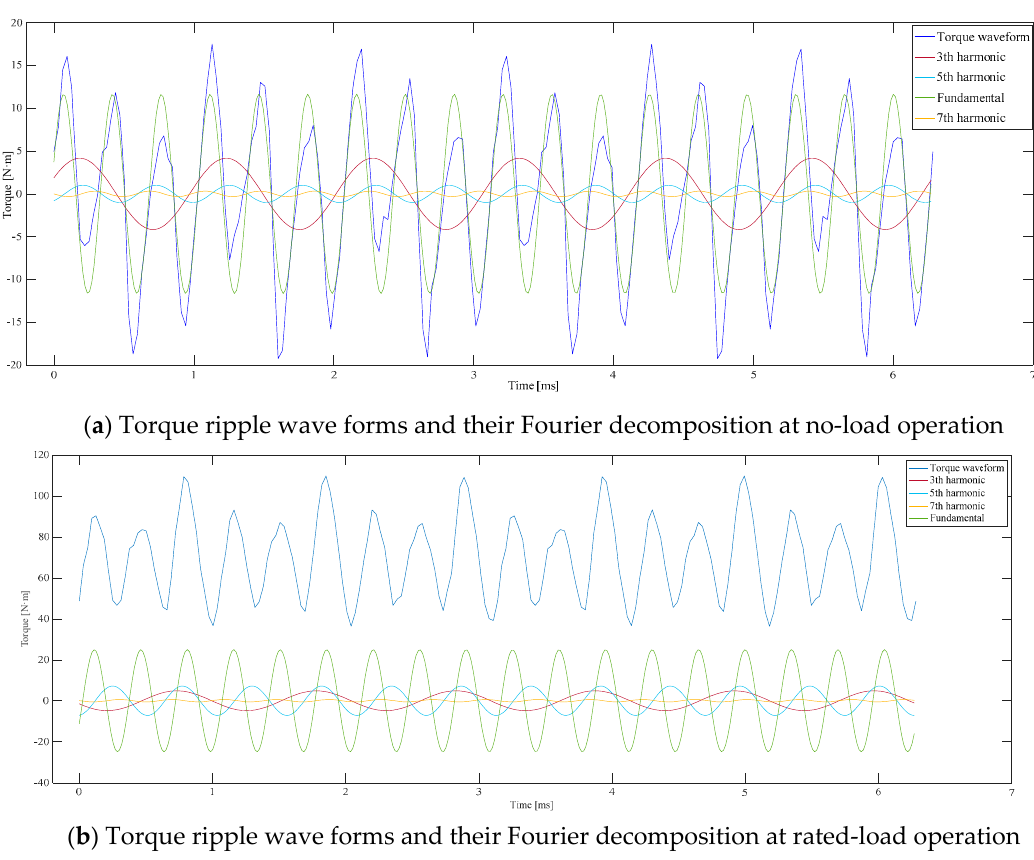
Figure 5. Torque ripple wave forms and their Fourier decomposition.